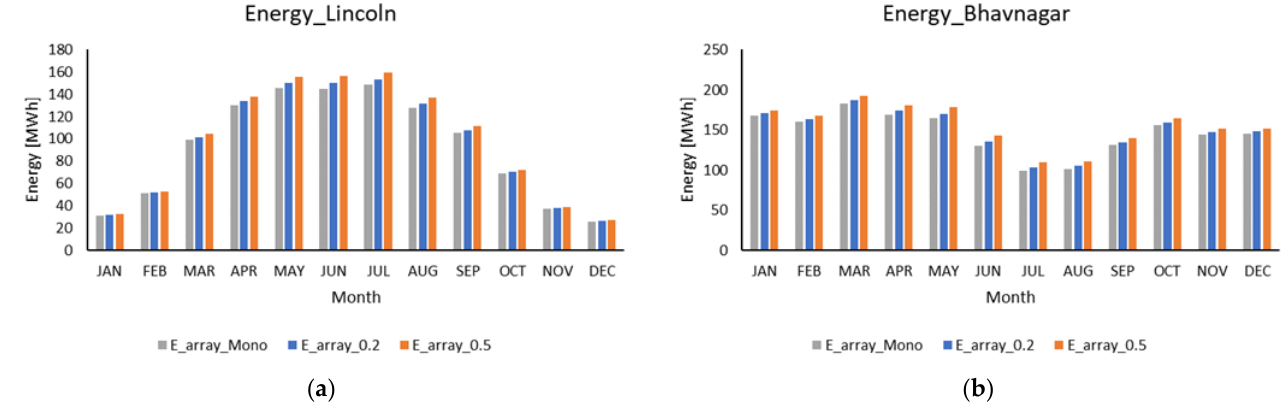
Figure 4. Monthly energy generation of the ( a ) Lincoln Solar Farm and ( b ) Bhavnagar Solar Farm.